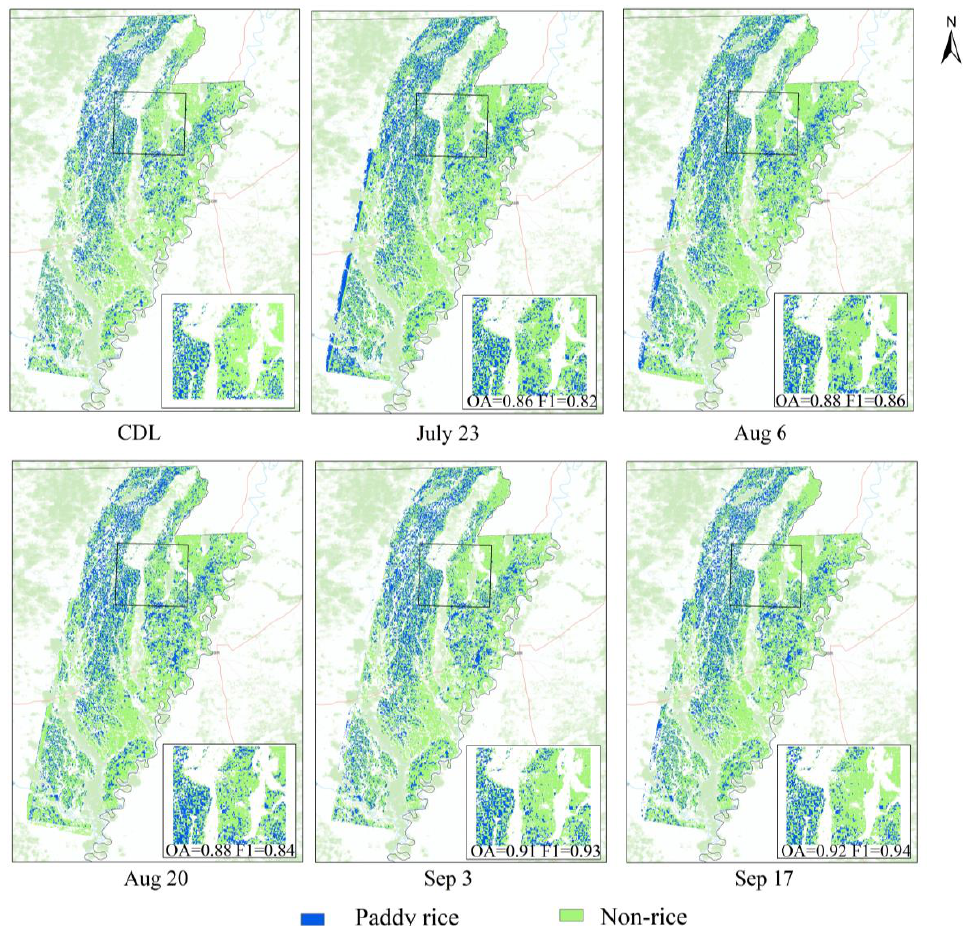
Figure 14. The dynamic maps of paddy rice in 2020 (Spatial resolution is 30 m). Time series starts on 16 April and the date represents the mapping date.